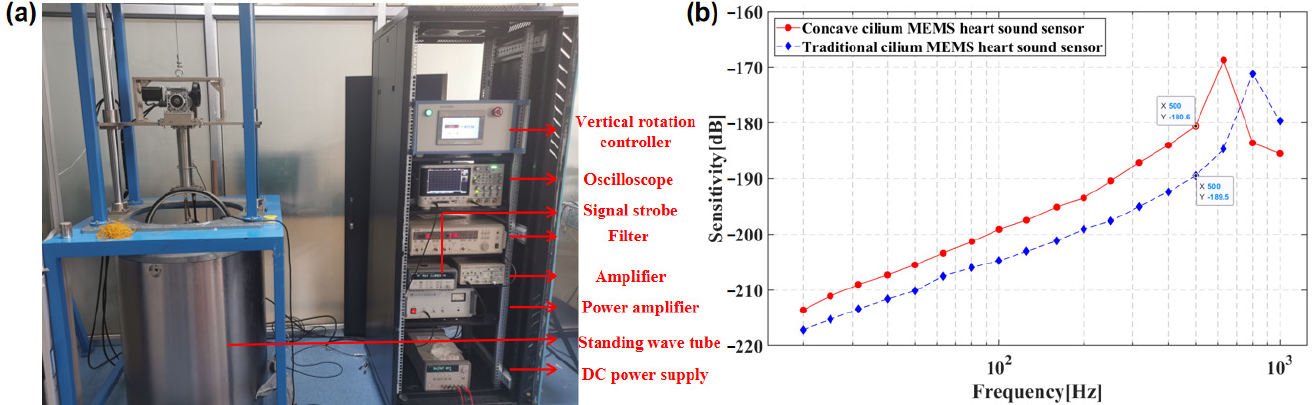
Figure 14. ( a ) Test of the standing wave tube calibration system. ( b ) Comparison diagram of sensor sensitivity test curve.